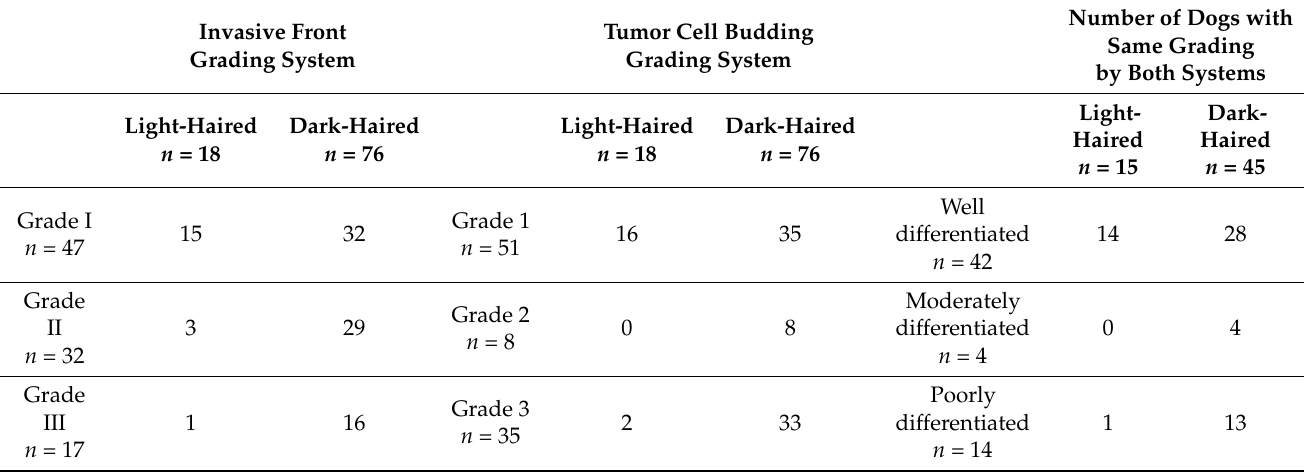
Table 4. Number of animals with digital squamous cell carcinoma in both invasive front grading system and tumor budding